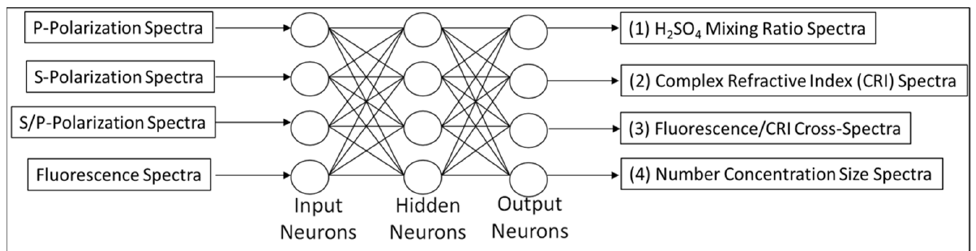
Figure 5. Machine learning will be implemented in the real time processor of the AFN to extract the critical information from the measurements.